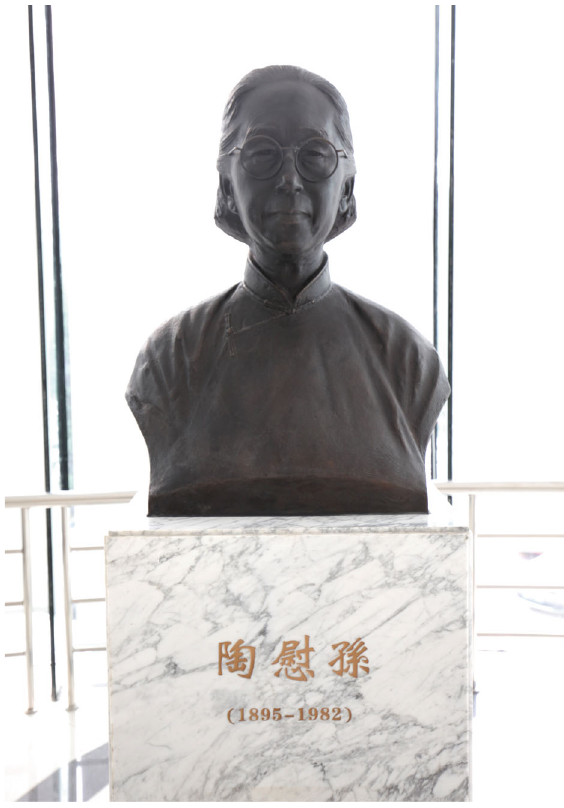
Figure 3. Bust of Professor Weisun Tao at Jilin